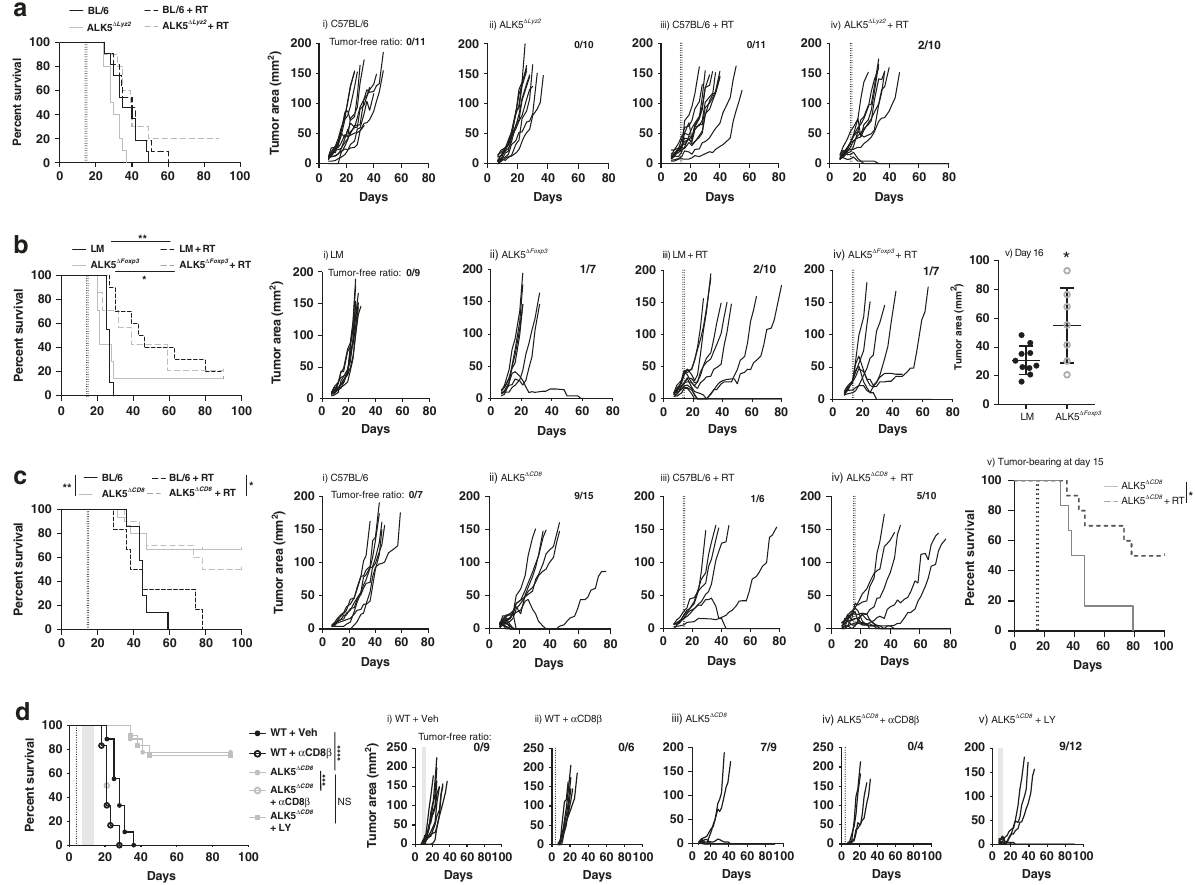
Fig. 2 CD8 α + cells are a direct target of TGF β RI mediated immune suppression. MC38 tumor-bearing animals underwent radiation in 2 consecutive doses of 10 Gy when tumors were 25 mm 2 . Mice were euthanized when tumors reached 144 mm 2 . a Survival curves for C57BL/6 ( n = 11), Lyz2Cre- derived using log-rank test. Shown is the compilation of 2 independent experiments. b Tumor growth and survival of littermate control (LM) ( n =